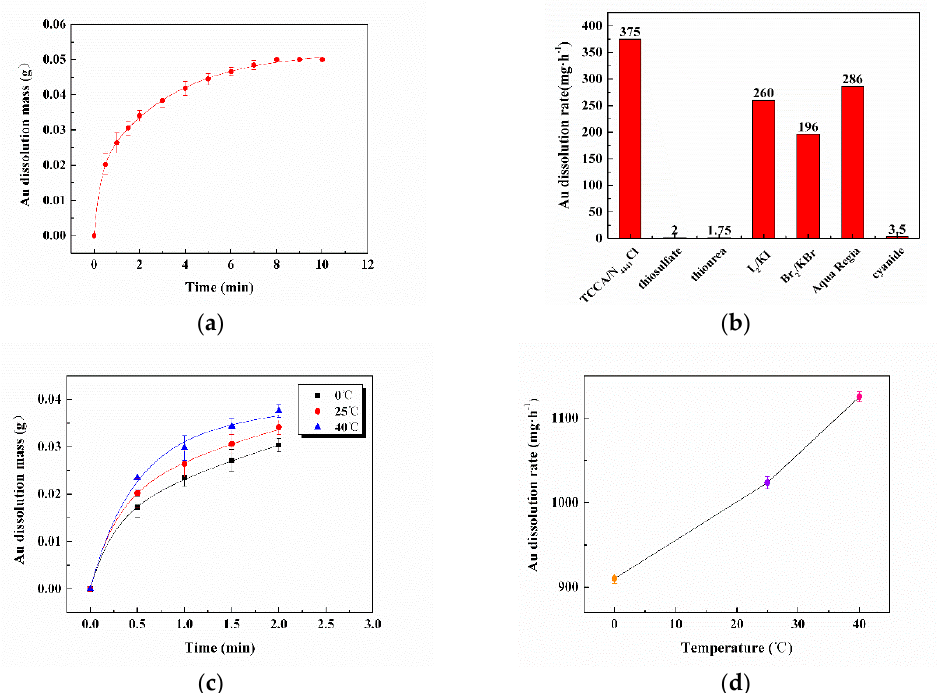
Figure 3. ( a ) The dissolution rate curve of Au by TCCA/N 4441 Cl at 25 °C; ( b ) comparison of average dissolution rates at 25 °C obtained with the literature [34] (the reagents of the methods mentioned are TCCA 0.16 M, N 4441 Cl 1.59 M; (NH 4 ) 2 S 2 O 3 0.3 M, NH 3 0.3 M, CuSO 4 0.01 M; CH 4 N 2 S 0.263 M, Fe 2 (SO 4 ) 3 0.02 M, H 2 SO 4 0.15 M; I 2 0.08 M, KI 0.80 M; Br 2 0.20 M, KBr 0.67 M; Aqua Regia (HCl: HNO 3 = 3:1); KCN 0.14 M, respectively); ( c ) the dissolution rate curve of Au by TCCA/N 4441 Cl at different temperatures; ( d ) correlation diagram between the rate of Au dissolution and temperature.